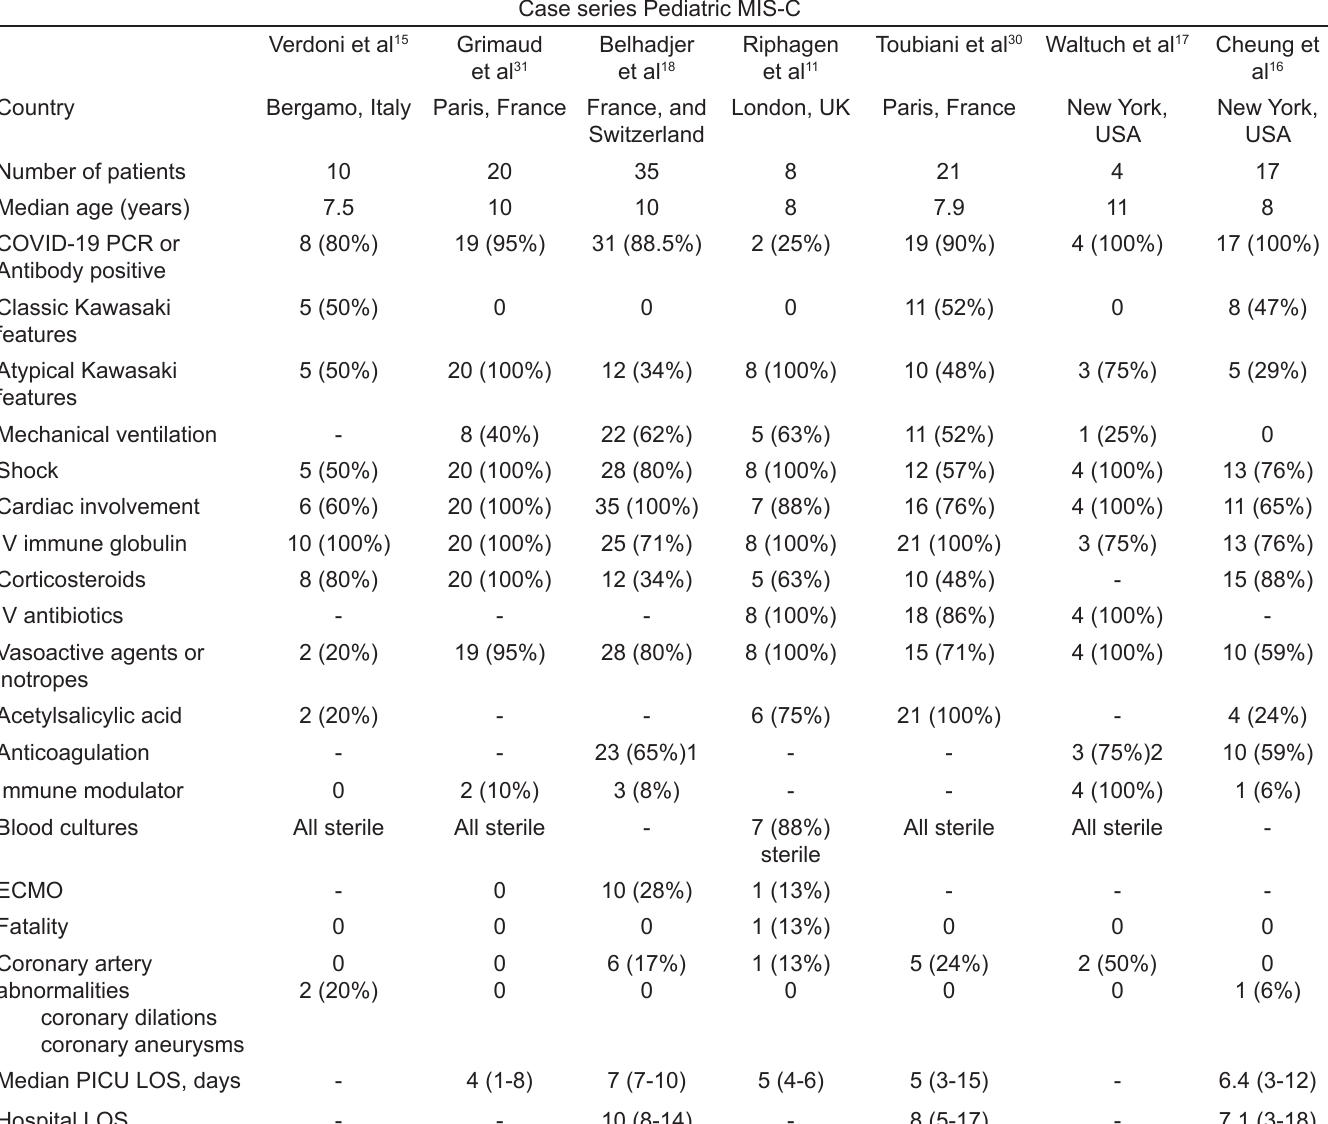
Table 3. Case series of pediatric multisystem inflammatory syndrome in children (MIS-C). Summary of currently published data of MIS-C patient presentations, treatments, and outcomes. Cardiac involvement includes myocarditis and ventricular dysfunction. Anticoagulation was administered as heparin or